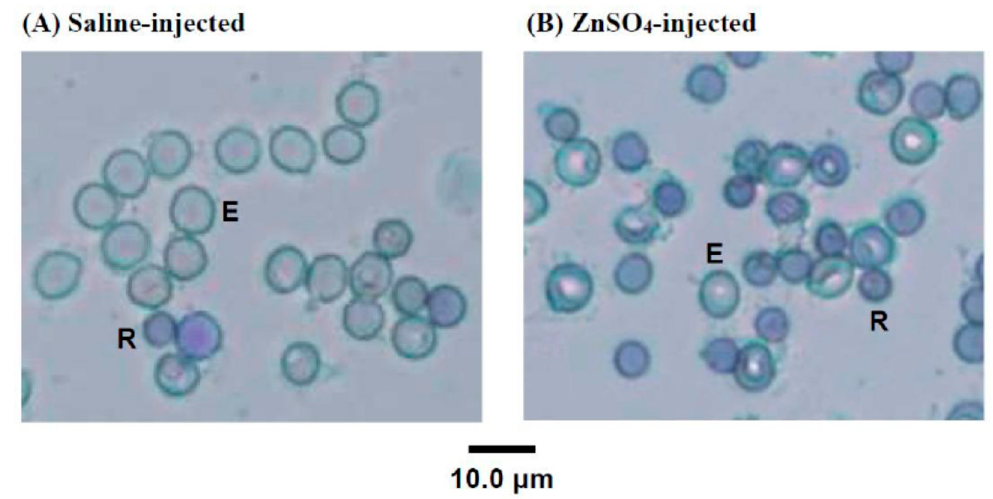
Figure 2. Microscopic observation of new methylene blue-stained blood cells of ( A ) saline-injected and ( B ) ZnSO 4 -injected 5 / 6-nephrectomized rats (27 days post surgery). In (A), most of the blood cells were mature erythrocytes (E) (median cell diameter 7.4 µ m), and their cytoplasm was clear. Several smaller cells (R) were also present. In (B), the ZnSO 4 -injected 5 / 6-nephrectomized rats had less mature erythrocytes (E) but had more smaller cells (R) (median cell size 5.1 µ m), and these cells (R) had curved linear structures or dark blue dots in the cytoplasm with distinctive staining of the reticulocytes.